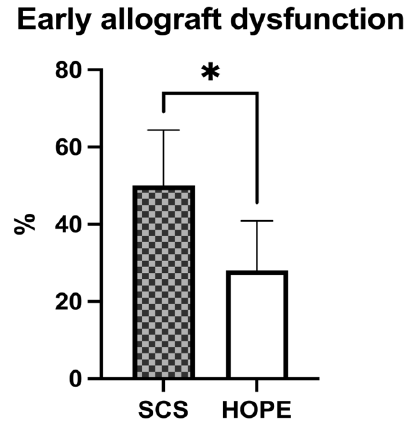
Figure 3. Graphical analysis of early allograft dysfunction in liver transplant recipients (Mean ± 95% ‐ CI). HOPE preconditioning results in significantly lower incidence of EAD within the first seven postoperative days, as compared to SCS. (* = p <